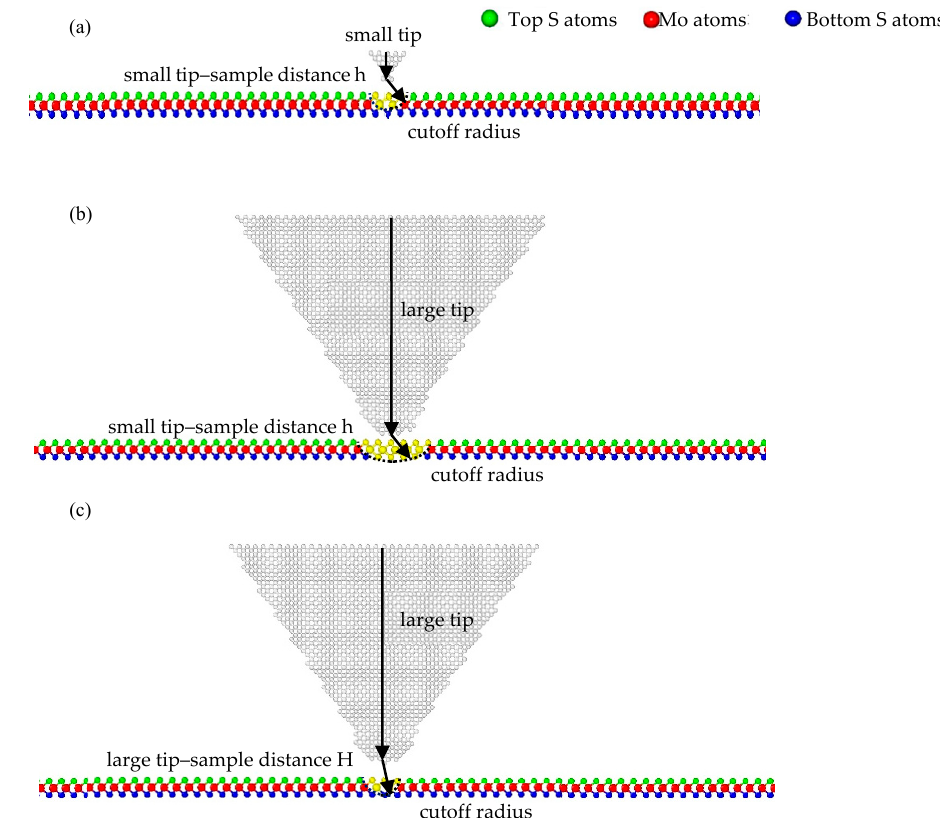
Figure 6. Schematic diagrams for tips of various radius during sliding: ( a ) small tip at small tip–sample distance h; ( b ) large tip at small tip–sample distance h; ( c ) large tip at large tip–sample distance H. Yellow regions represent the range of influence of the Van der Waals force for tips with various radii.